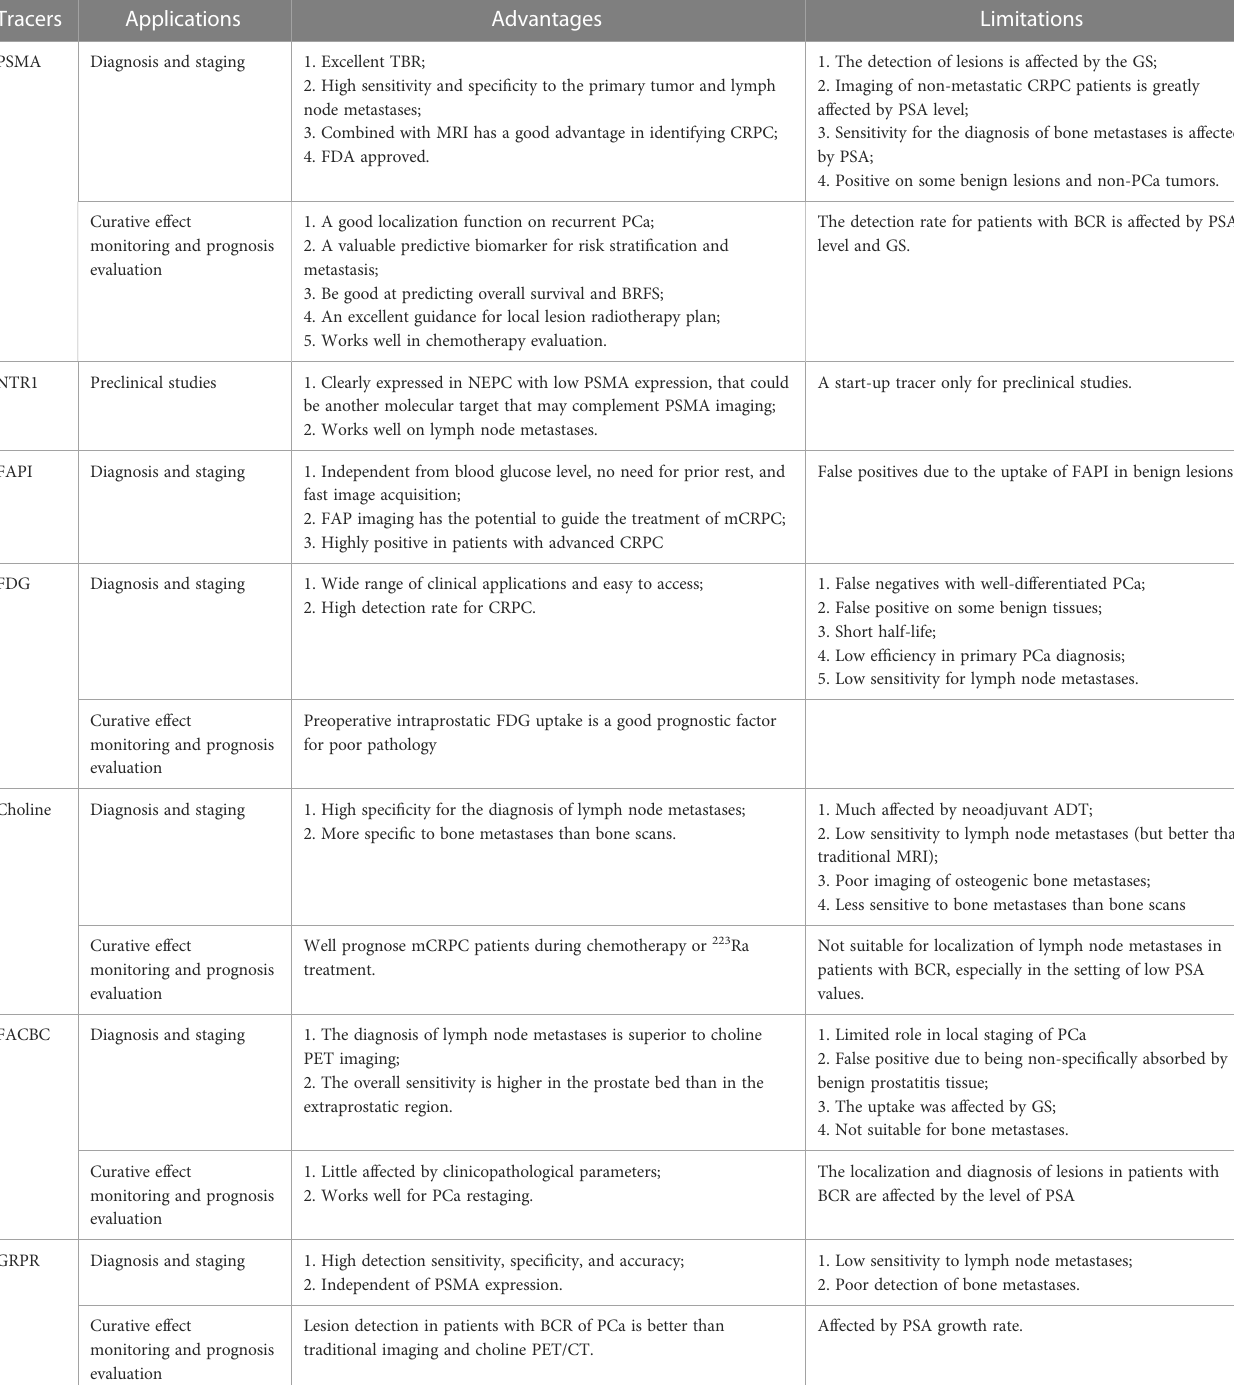
TABLE 1 Pros and cons of PET imaging agents for prostate